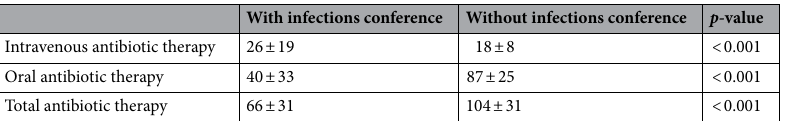
With infections conference Without infections conference p -value